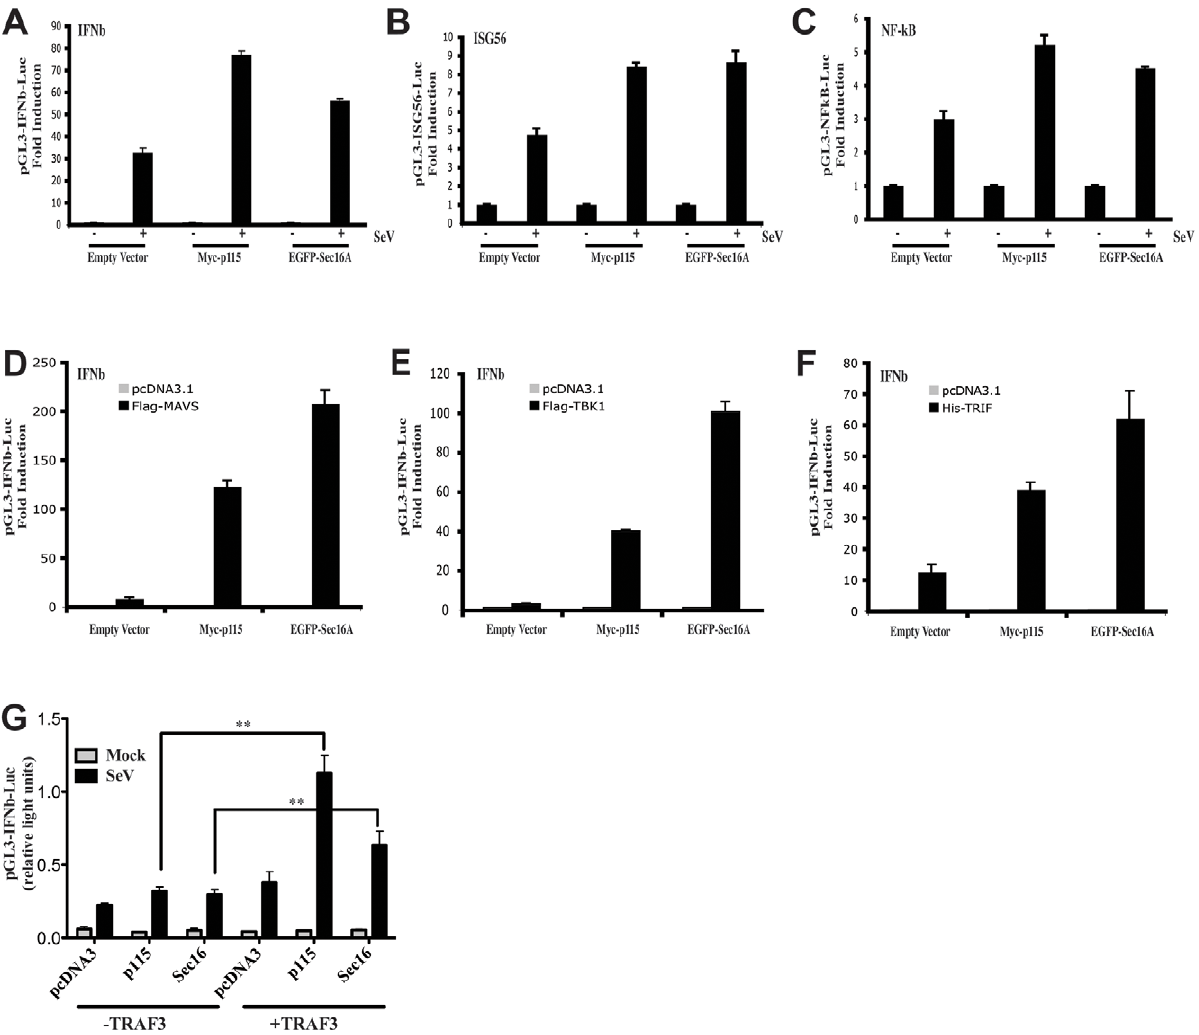
Figure 8. Sec16A and p115 influence the type I IFN antiviral response at the transcriptional level. ( A–C ) Hec1B cells were co-transfected with the indicated luciferase reporter genes together with 125 ng of empty vector, Myc-p115 or EGFP-Sec16A. Data are expressed as fold-induction following SeV infection (16 h) over the corresponding non-infected condition. ( D–F ) Hec1B cells were co-transfected with pGL3-IFN b -luciferase reporter gene together with 125 ng of empty vector, Myc-p115 or Sec16A and 15 ng of FLAG-MAVS ( D ), 100 ng of FLAG-TBK1 ( E ), or 15 ng of His- TRIF ( F ). Data represent the fold-activation over the corresponding vector control. Each value represents the mean + / 2 S.D. of triplicate determinations. The data are representative of at least four different experiments with similar results. ( G ) TRAF3 knockout MEF cells were co- transfected with 250 ng of luciferase reporter plasmid pGL3-IFN b , 500 ng of pcDNA3 or FLAG-TRAF3 plasmid and 375 ng of indicated plasmids. At 24 h post-transfection, cells were left uninfected or infected with SeV (200 HAU/ml) for 16 h and relative luciferase activity was measured as described in Materials and Methods. Mean values + / 2 S.D. of triplicate determinations are shown (** P , 0.01). One of three independent experiments with similar results is